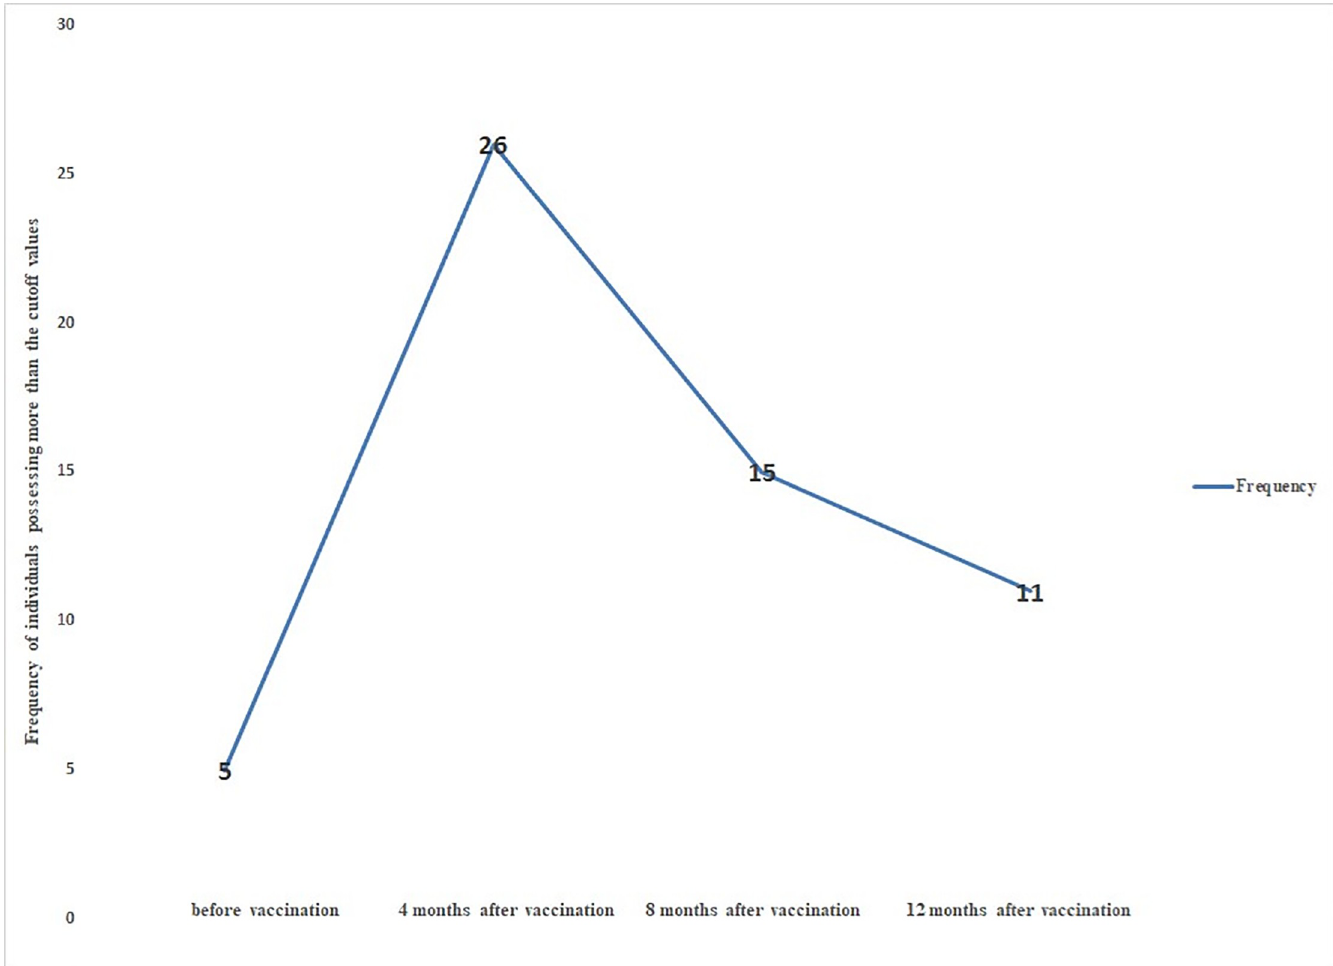
Fig 2. The frequency of individuals possessing more than the cutoff values at different intervals post